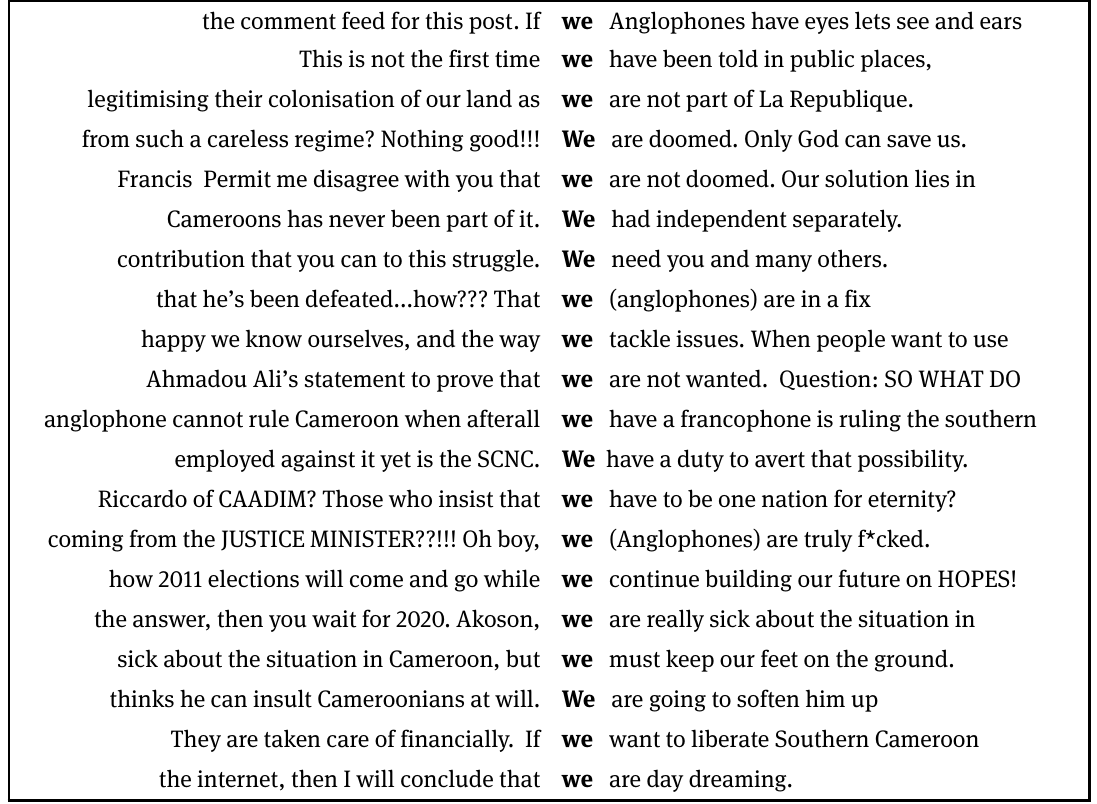
Figure 3. Sample concordance list for